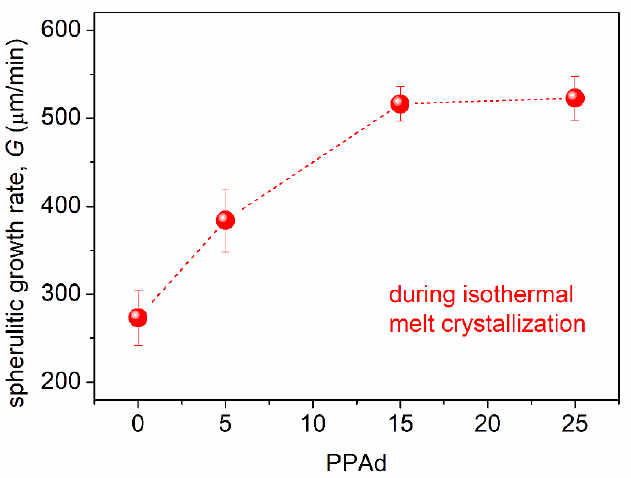
Figure 7. The PPAd dependence of the spherulitic growth rate evaluated during melt-crystallization of the PLA-based systems.